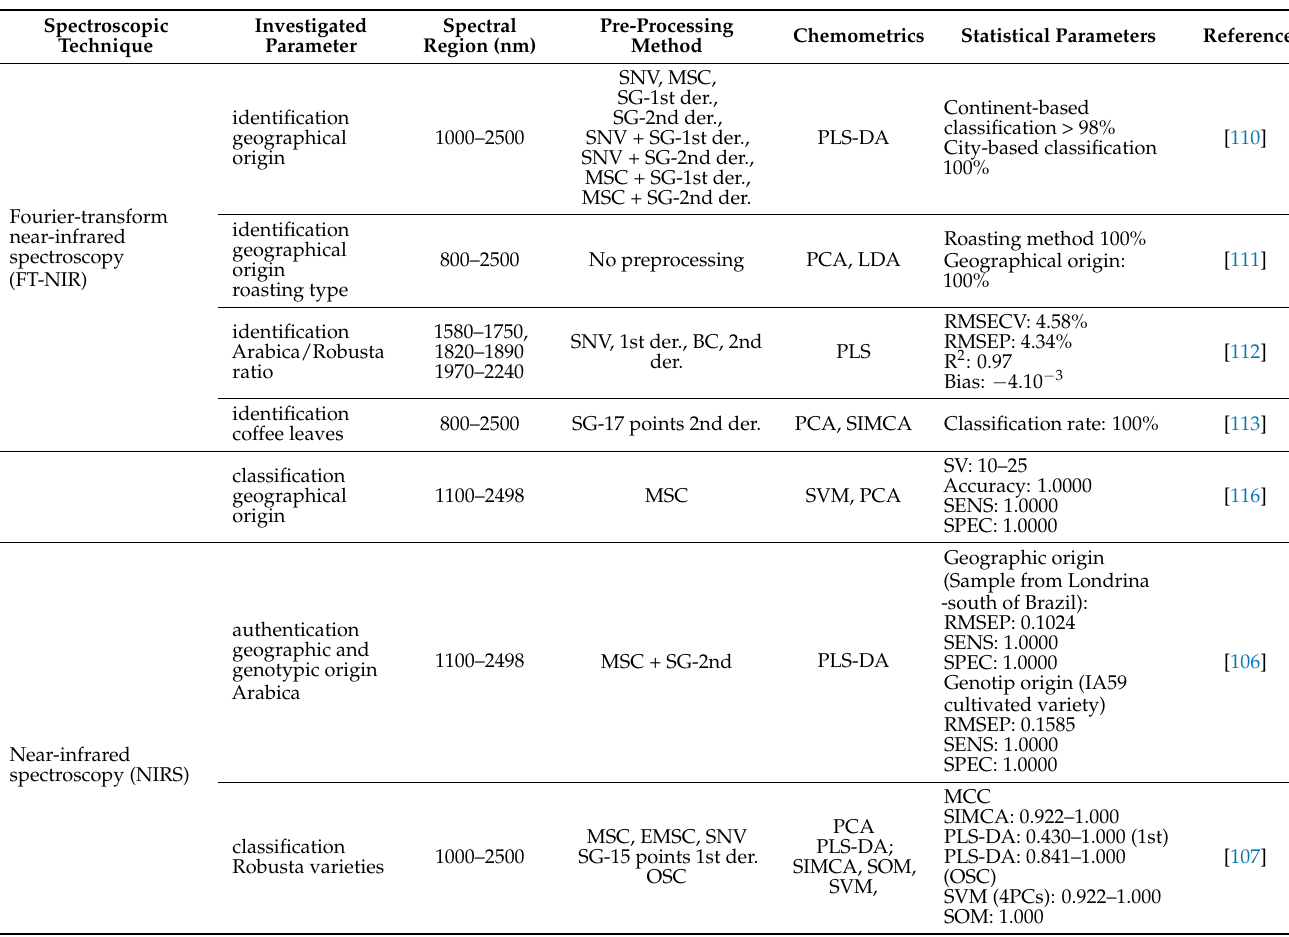
Table 7. Overview of molecular spectroscopic techniques for authentication and adulteration deter- mination in coffee bean, roasted coffee, and grounded